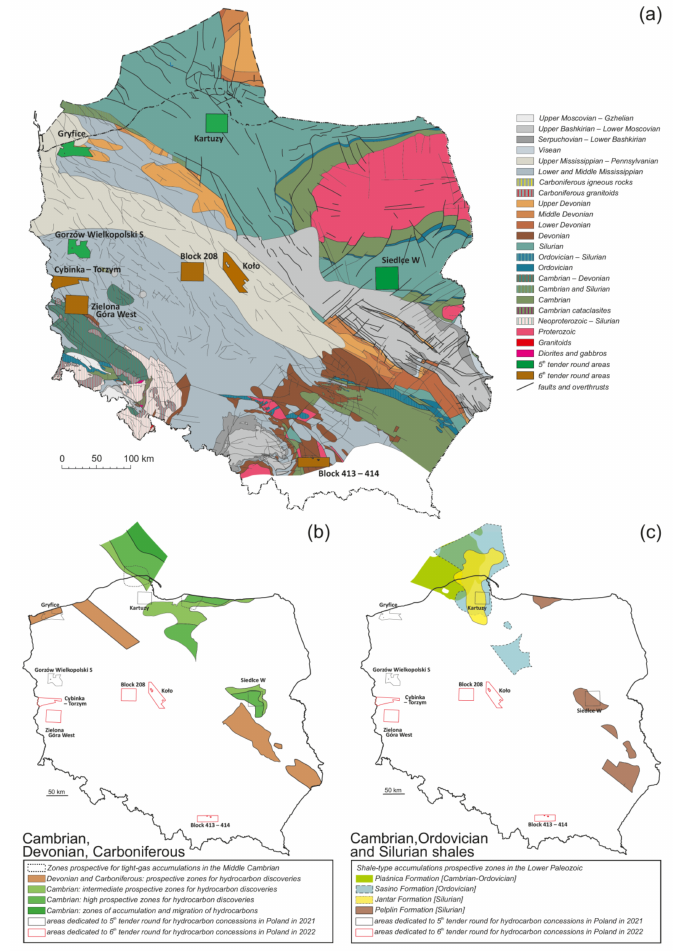
Figure 3. Location of the areas dedicated to the 5th and 6th tender rounds for hydrocarbon conces- sions: ( a ) on the Geological map of Poland without Permian and younger deposits ([44], simplified); ( b ) in relation to the prospective areas for conventional hydrocarbon accumulations in the Cam- brian [45,46], Devonian, and Carboniferous ([47]; see also [48–50]) and prospective areas for tight-gas accumulations in the Middle Cambrian [27,37,39]; ( c ) in relation to the prospective areas for uncon- ventional hydrocarbon accumulations in Lower Paleozoic shale formations